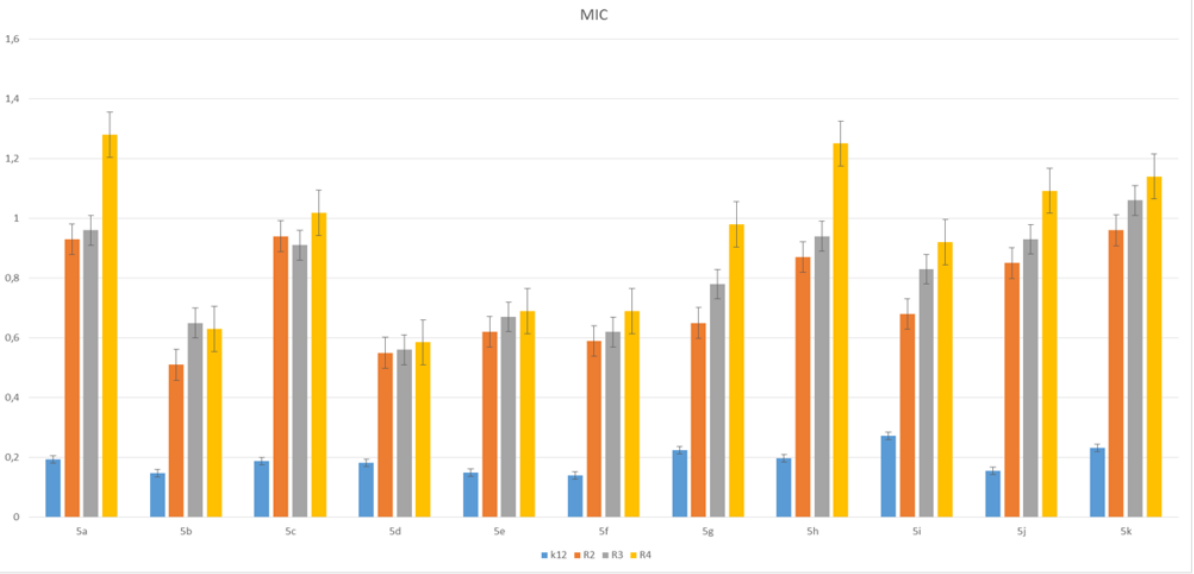
Figure 3. Minimum inhibitory concentration (MIC) of the pyridine derivatives in model bacterial strains. The x -axis 11 compounds were used sequentially. The y -axis shows the MIC value in µg/mL −1 .